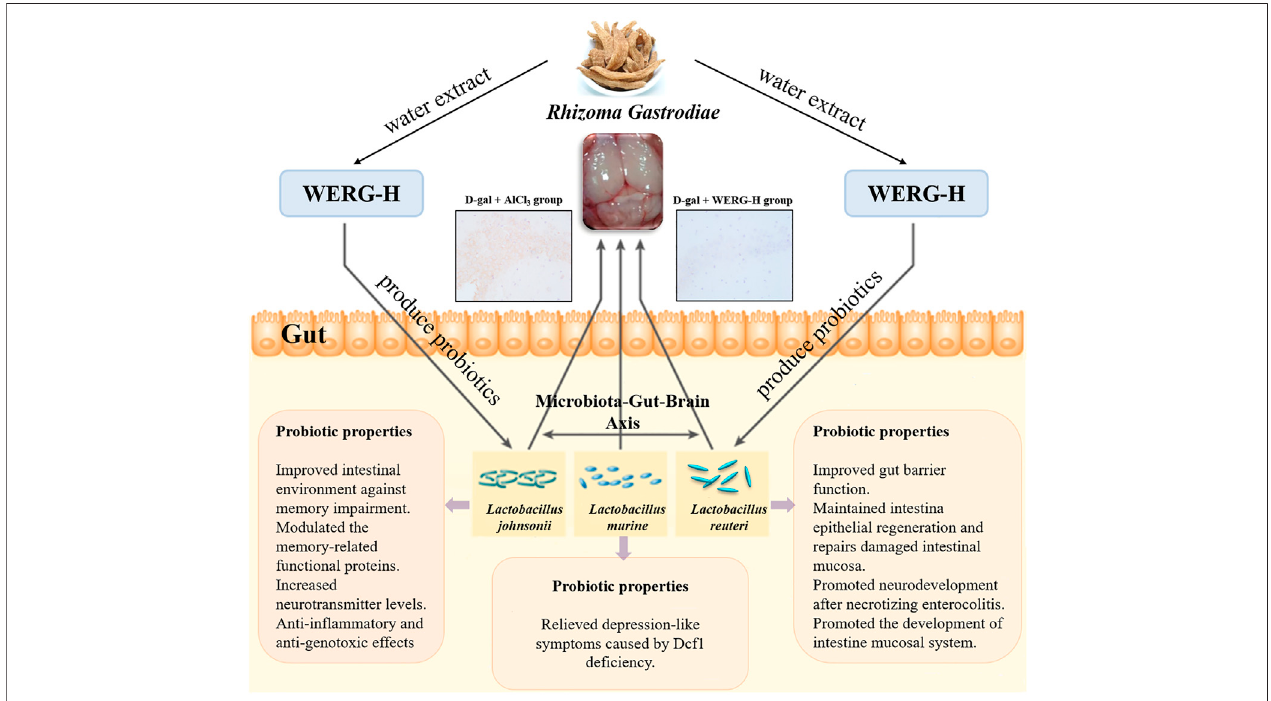
FIGURE8| Bene fi cialeffectsofWERG-HagainstADmodelmousemaybeduetoinhibitionofp-Tau Thr231 proteinexpression,ameliorationofp-Tau Thr231 -induced toxicity, and alleviation of gut microbiota dysbiosis by enriching probiotics. Finally, through the microbiota – gut – brain axis to improve D-gal/AlCl 3 -induced cognitive impairment.